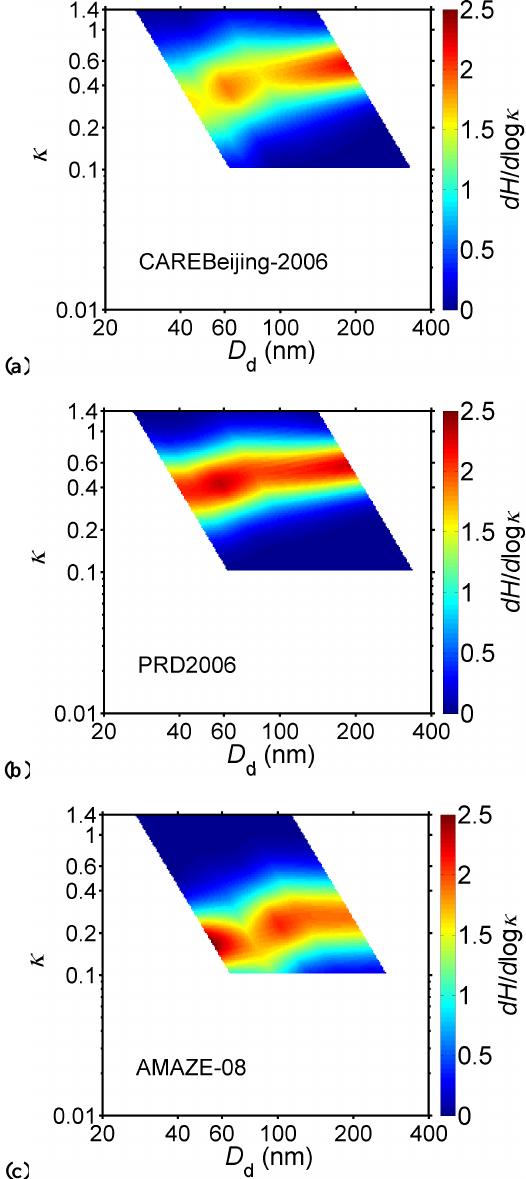
Fig. 9. Average logarithmic probability distributions of particle hy- groscopicity, dH(κ,D d )/d log κ , plotted over effective hygroscopic- ity parameter ( κ ) and dry particle diameter ( D d ) for CAREBeijing- 2006 (a) , PRD2006 (b) and AMAZE-08 (c) . The dH(κ,D d )/d log κ curves from the Fig. 8b were interpolated over the D d – κ plane by using a 2-D triangle-based linear interpolation